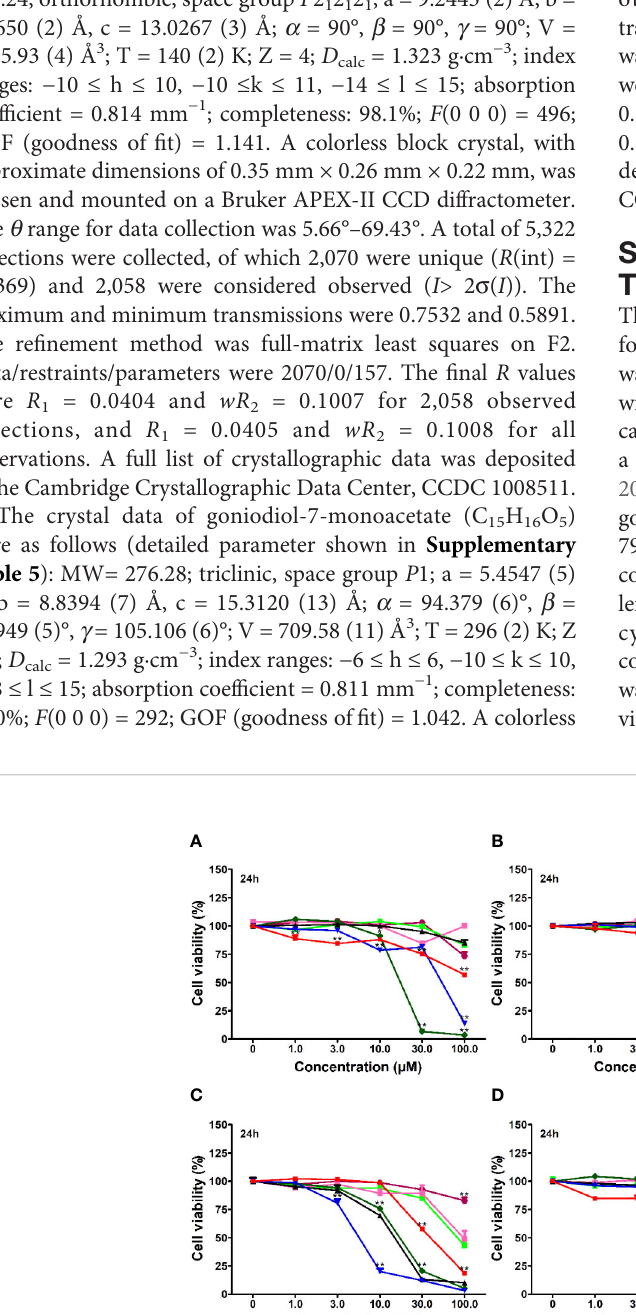
FIGURE 3 | Styryllactones inhibited proliferation of tumor cell lines. The cells (5×10 4 cells/ml) were cultured in the absence or presence of various compounds (1.0, 3.0, 10.0, 30.0, 100.0 m M) for 24 h. VP-16 (1.0, 3.0, 10.0, 30.0, 100.0 m M) were used as a positive control. (A) SGC-7901 cell line; (B) SMMC-7721 cell line; (C) SW1116 cell line; (D) HepG2 cell line. Data are means ± standard error of the mean (SEM) ( n =3). Results are representative of three separate experiments. *P <0.05, **P <0.01 compared with the group (cell viability in 0 m